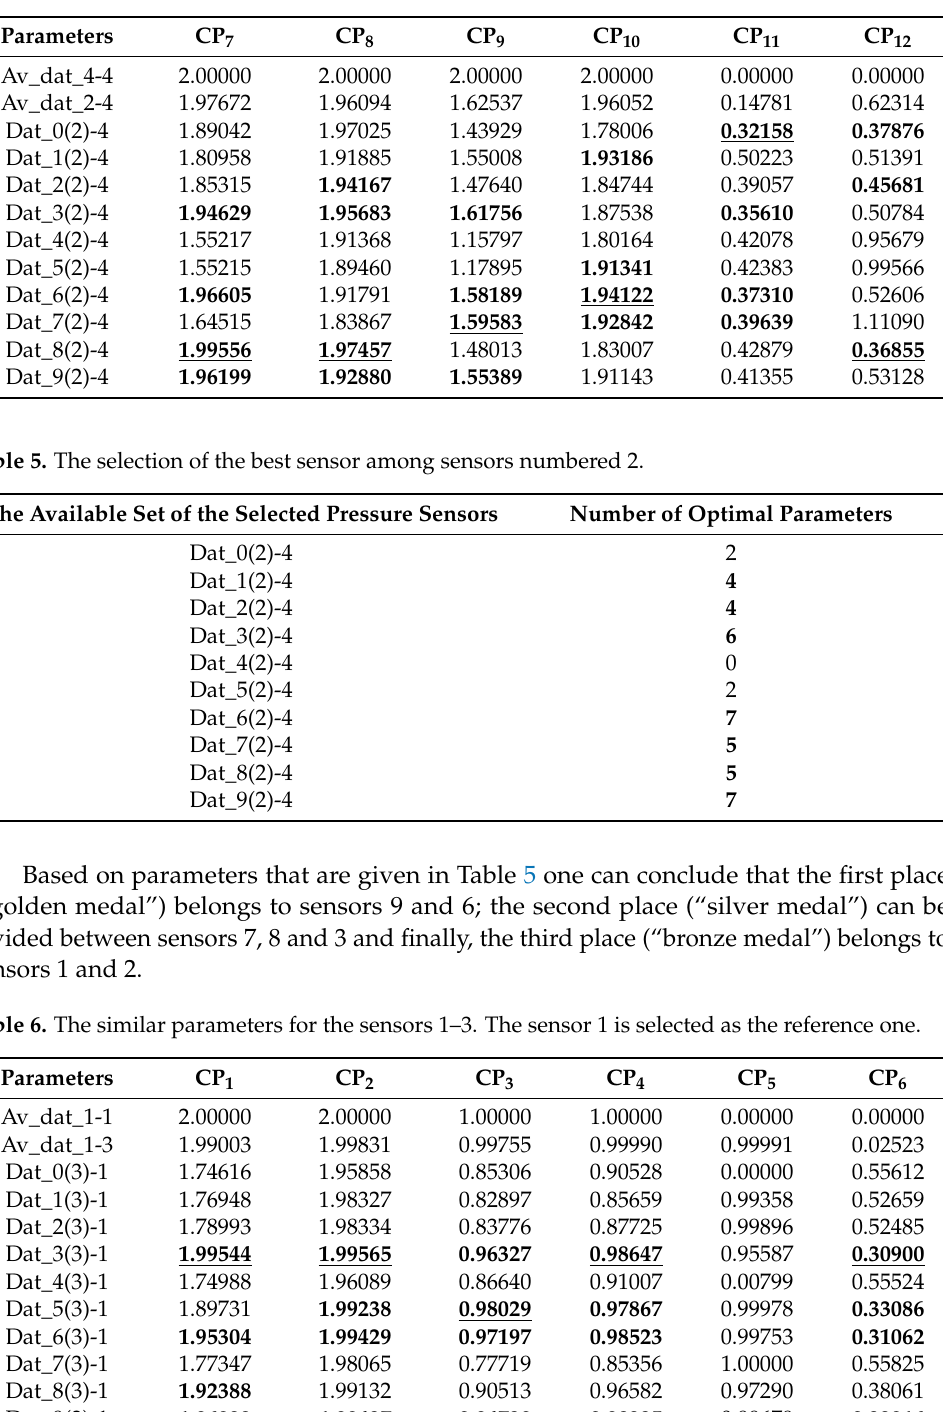
Table 4. Additional correlation parameters that were extracted from complex moments.